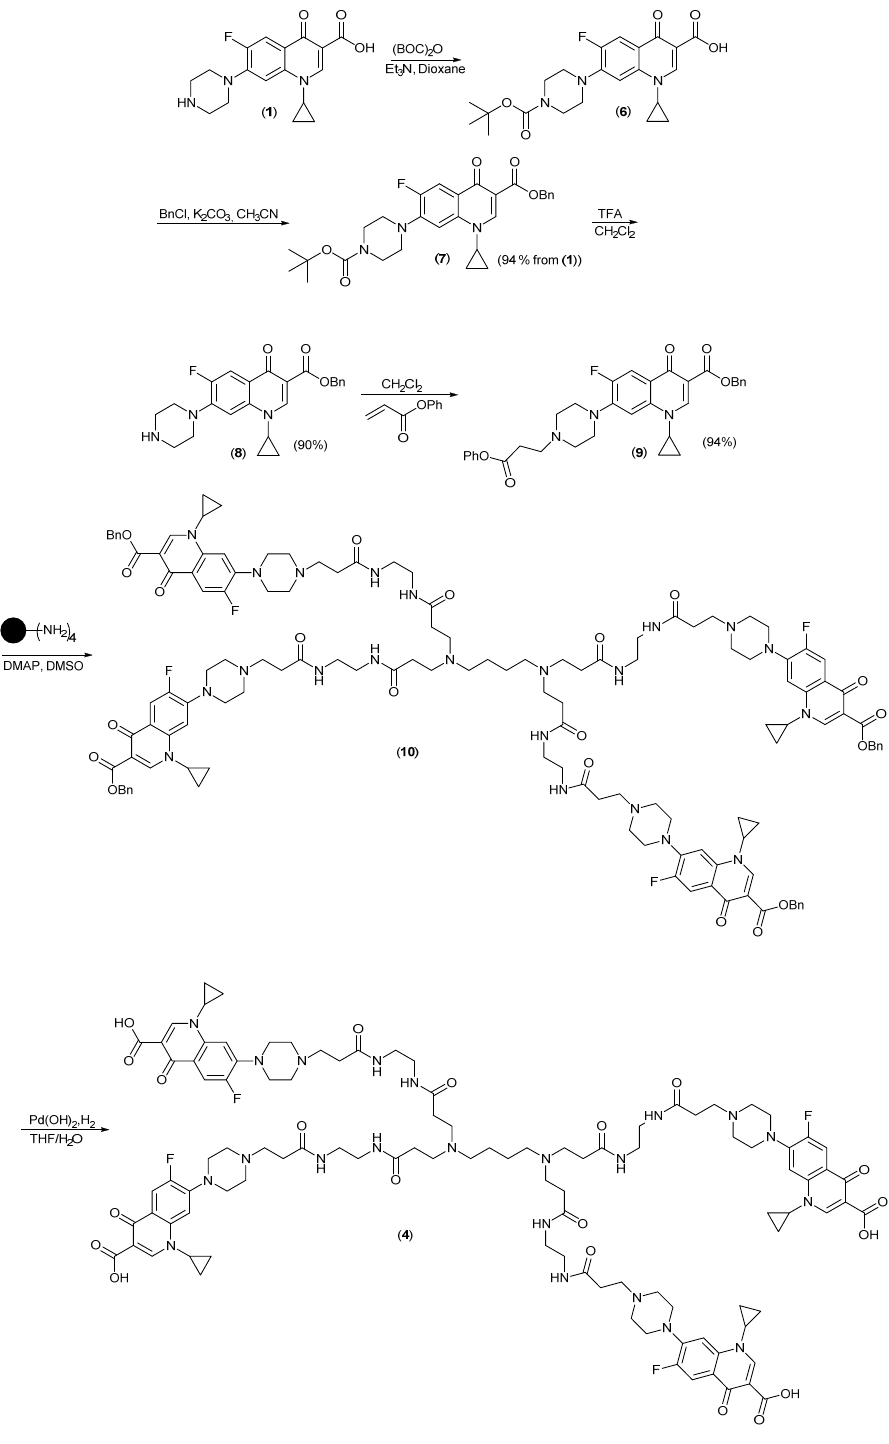
Scheme 1. Synthesis of the PAMAM-Ciprofloxacin conjugate ( 4 ) from Ciprofloxacin ( 1